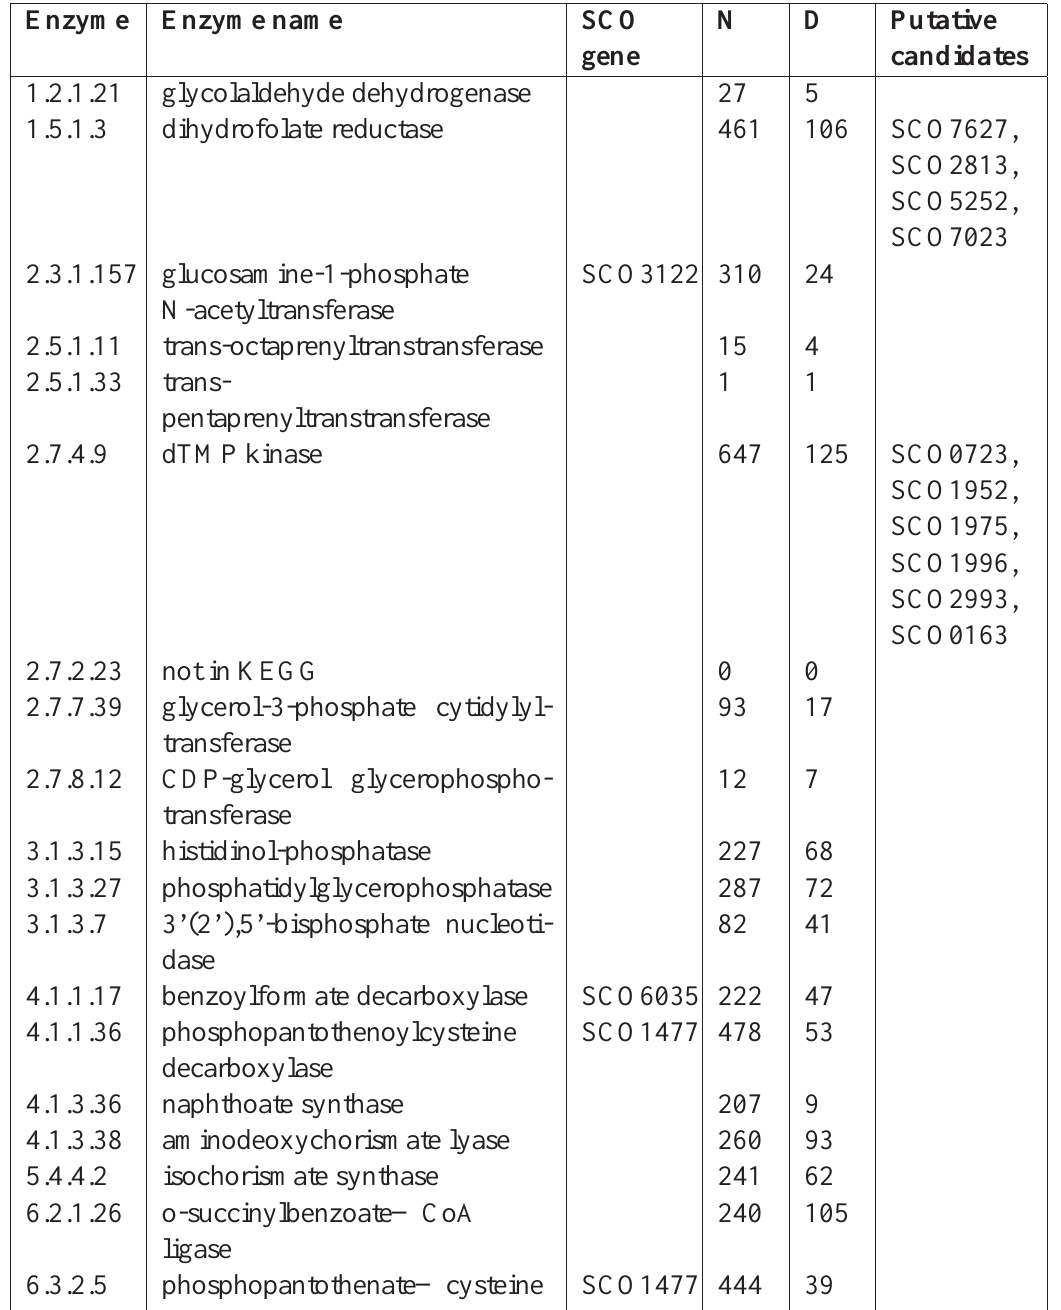
Table 1: Missing essential enzymes (with four figure E.C. numbers) from Borodina et al. [4], N is the number of genes associated with the E.C. number from KEGG; D gives a measure of diversity as described in the text; column 6 suggests putative candidates from searching the as-yet unannotated S. coelicolor